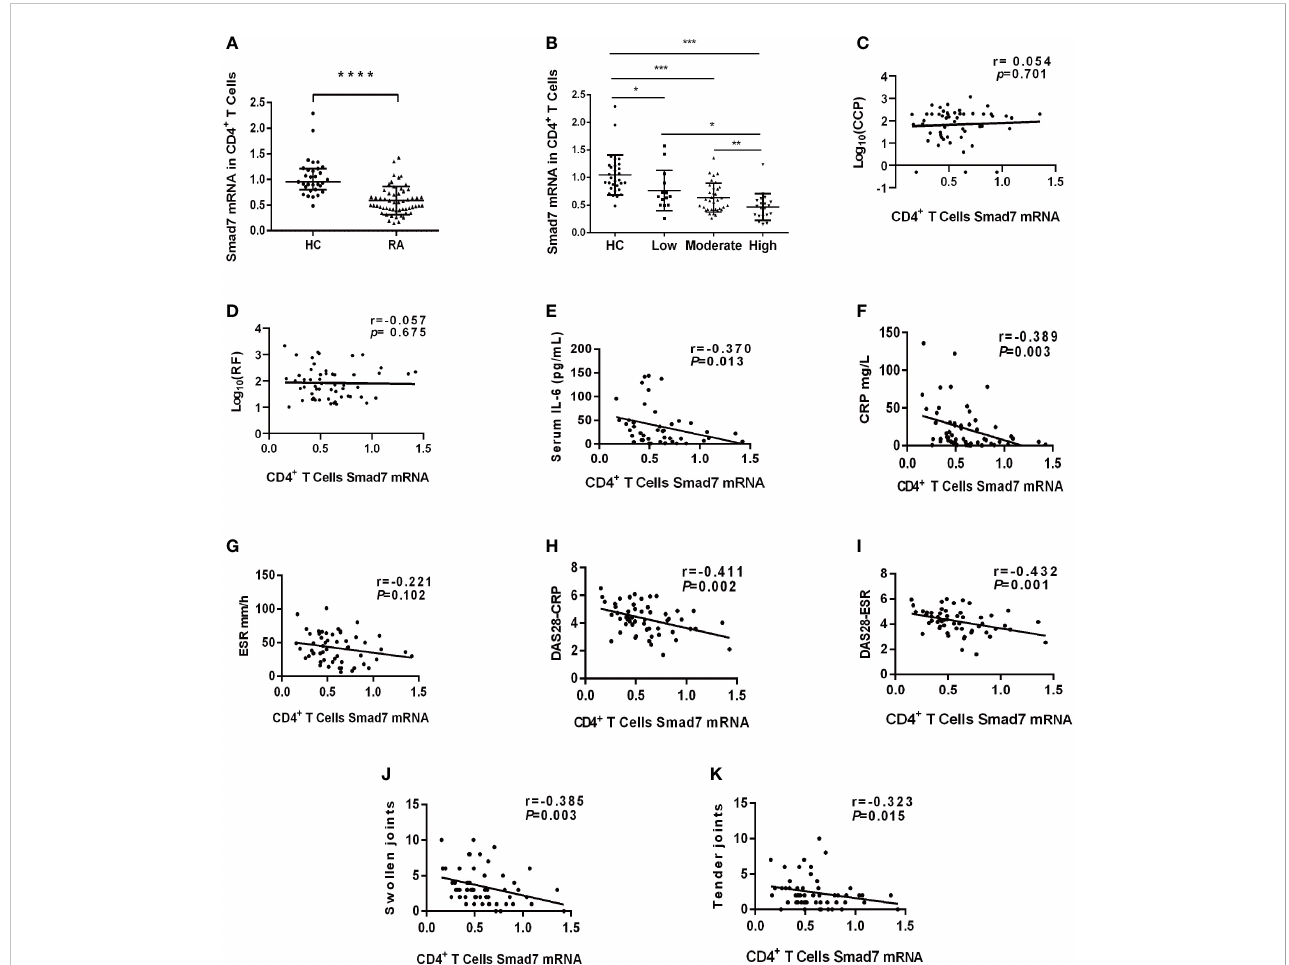
FIGURE 2 The expression of Smad7 in peripheral CD4 + T cells and its correlation with clinical indexes in RA patients. (A) Expression of Smad7 mRNA in peripheral CD4 + T cells of RA patients (n=57) and health controls (n=35). (B) Levels of Smad7 mRNA in CD4 + T cells of RA patients with different disease activities. (C, D) Correlation of CD4 + T cell Smad7 mRNA level with serum levels of CCP or RF in RA patients (n=56). (E – K) Correlation of CD4 + T cell Smad7 mRNA level with serum levels of IL-6, CRP, ESR, DAS28-CRP, DAS28-ESR, Swollen joints and Tender joints in RA patients (n=56). Each dot represents one individual and data are mean ± SD. *P < 0.05, **P < 0.01, ***P < 0.001, ****P < 0.0001 compared between